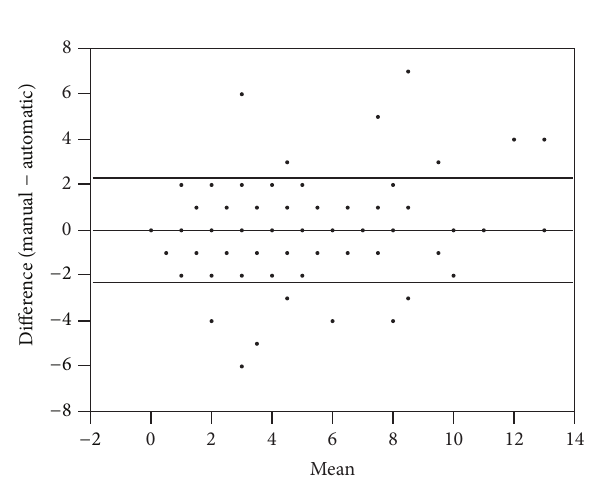
Figure 1: Derivation cohort: Bland-Altman plot of the manual versus automatic scores resulted in a mean difference of 0.02 ± 2.33 (SD, 𝑁 = 94 ). Note: plotted values frequently represent more than one patient sample.